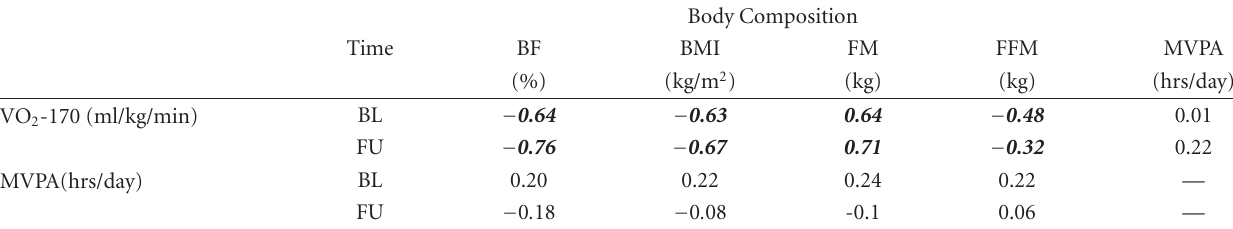
Table 3: Relationships between Body Composition, CV Fitness and Physical Activity levels at Baseline and Follow-up. (Pearson correlation coe ffi cients).